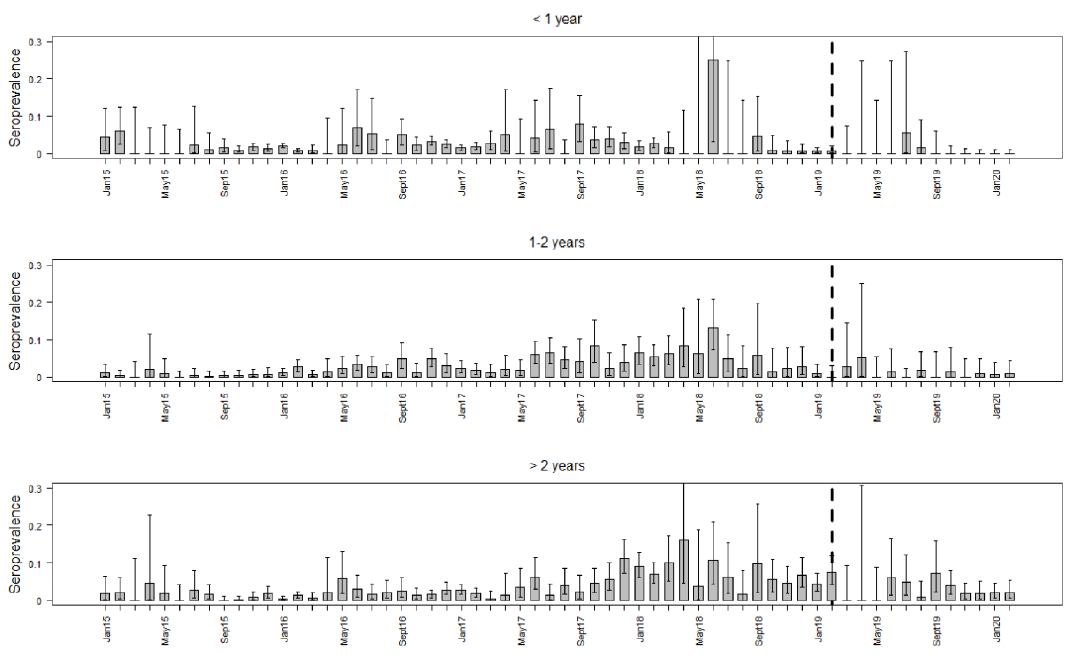
Figure 2. Prevalence estimates for seropositive wild boar that were ASFV PCR-negative for each study month and three different age classes. The whiskers indicate 95% confidence intervals. The broken vertical line highlights February 2019, when ASFV-positive wild boar were last detected by PCR.